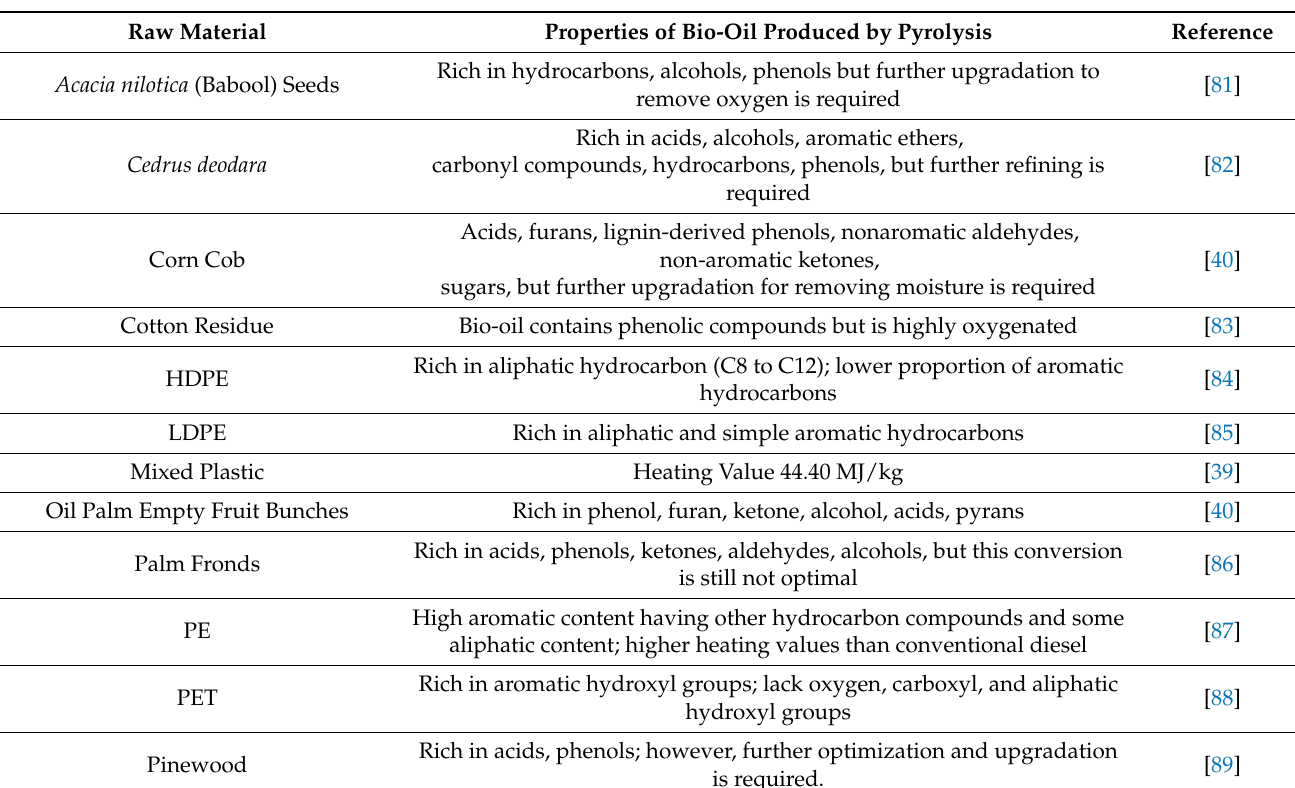
Table 2. Typical properties of bio-oil obtained from pyrolysis of different biodegradable (lignocellu- losic) and non-biodegradable